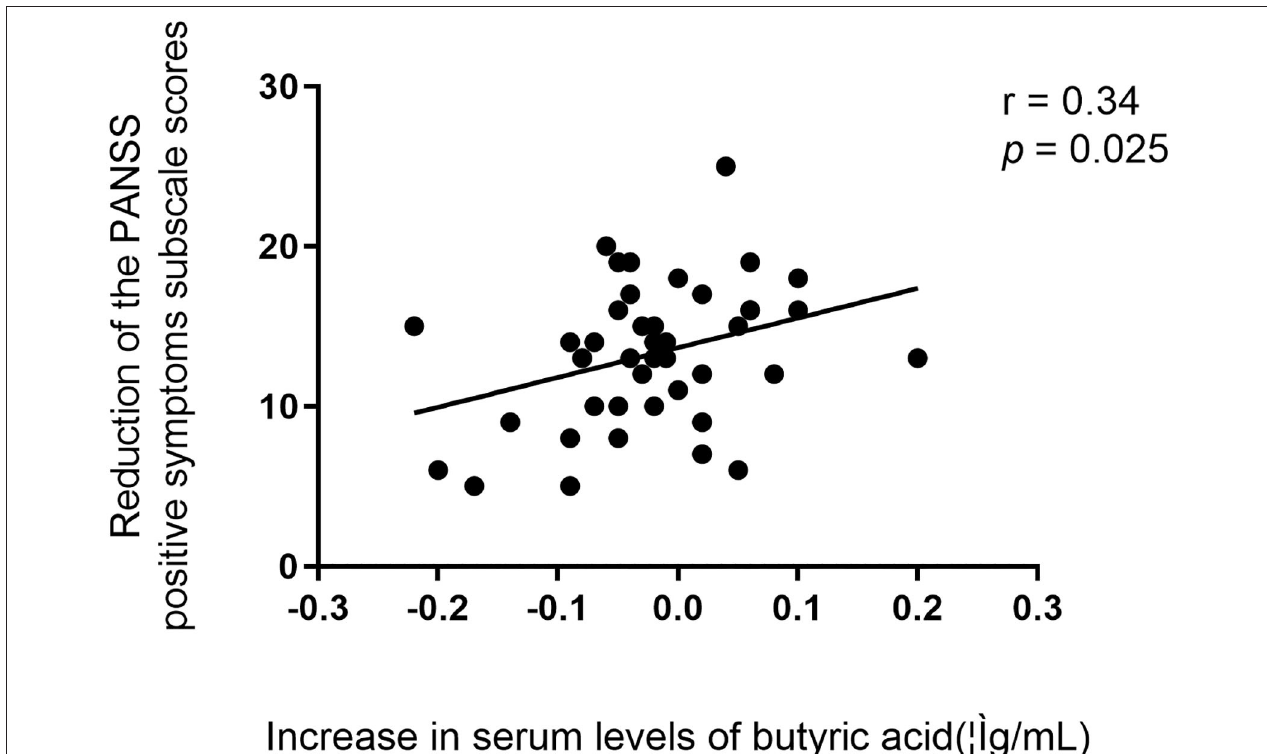
FIGURE 3 | Relationship between baseline serum levels of butyric acid and the reduction ratio of the PANSS total scores and all subscale scores in